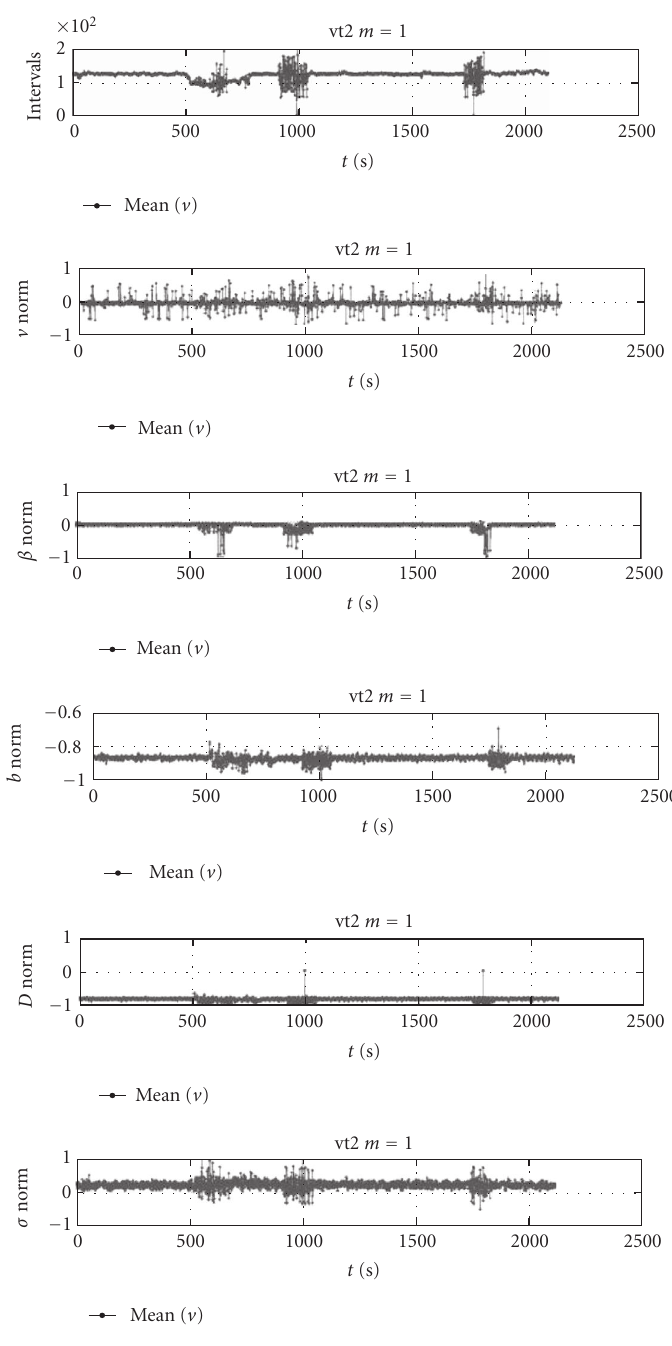
Figure 3.1. Interactive sensitivity of the main electrophysiological parameters to presence of